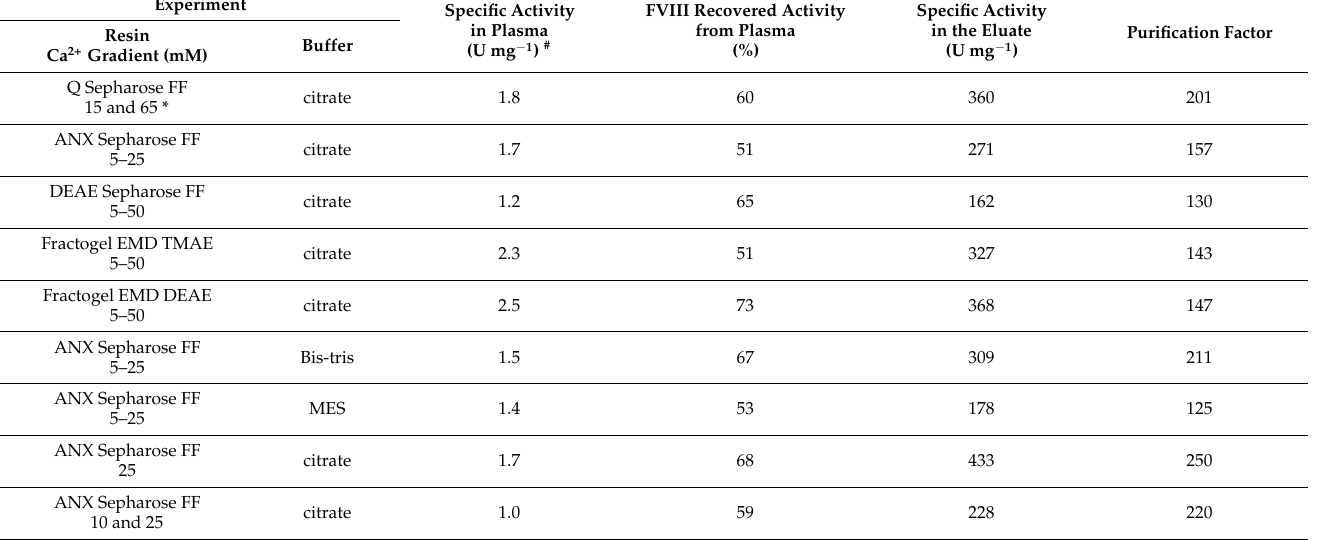
Table 1. FVIII purifications from